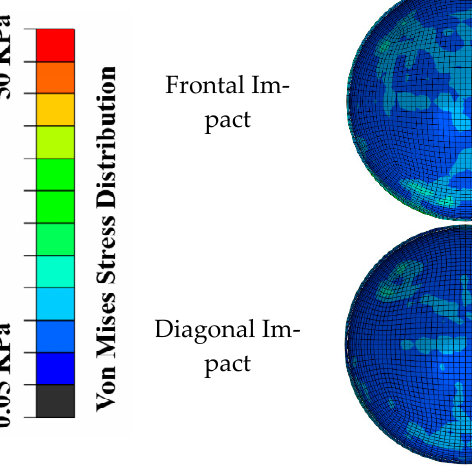
Figure 3. The distribution of von Mises stress in the posterior retina in frontal and diagonal impact scenarios at three different velocities.